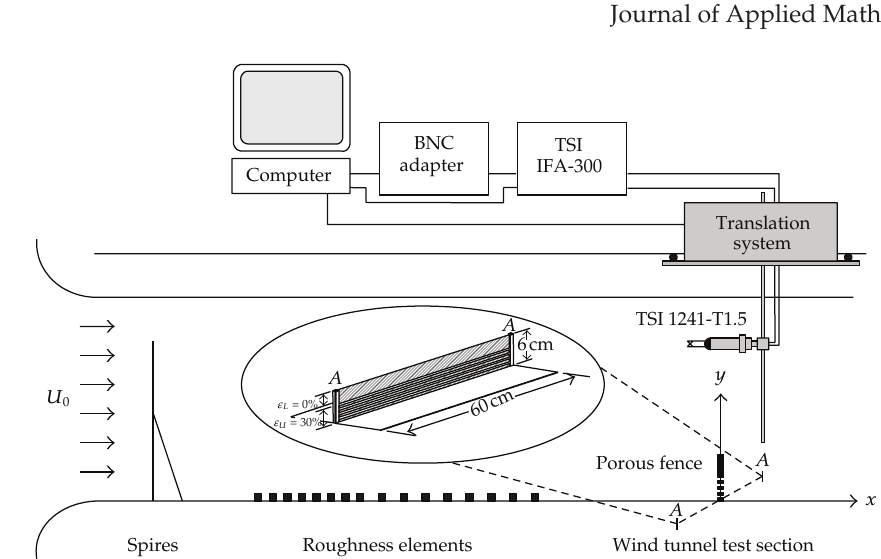
Figure 2: Schematic diagram of the porous fence and coordinate